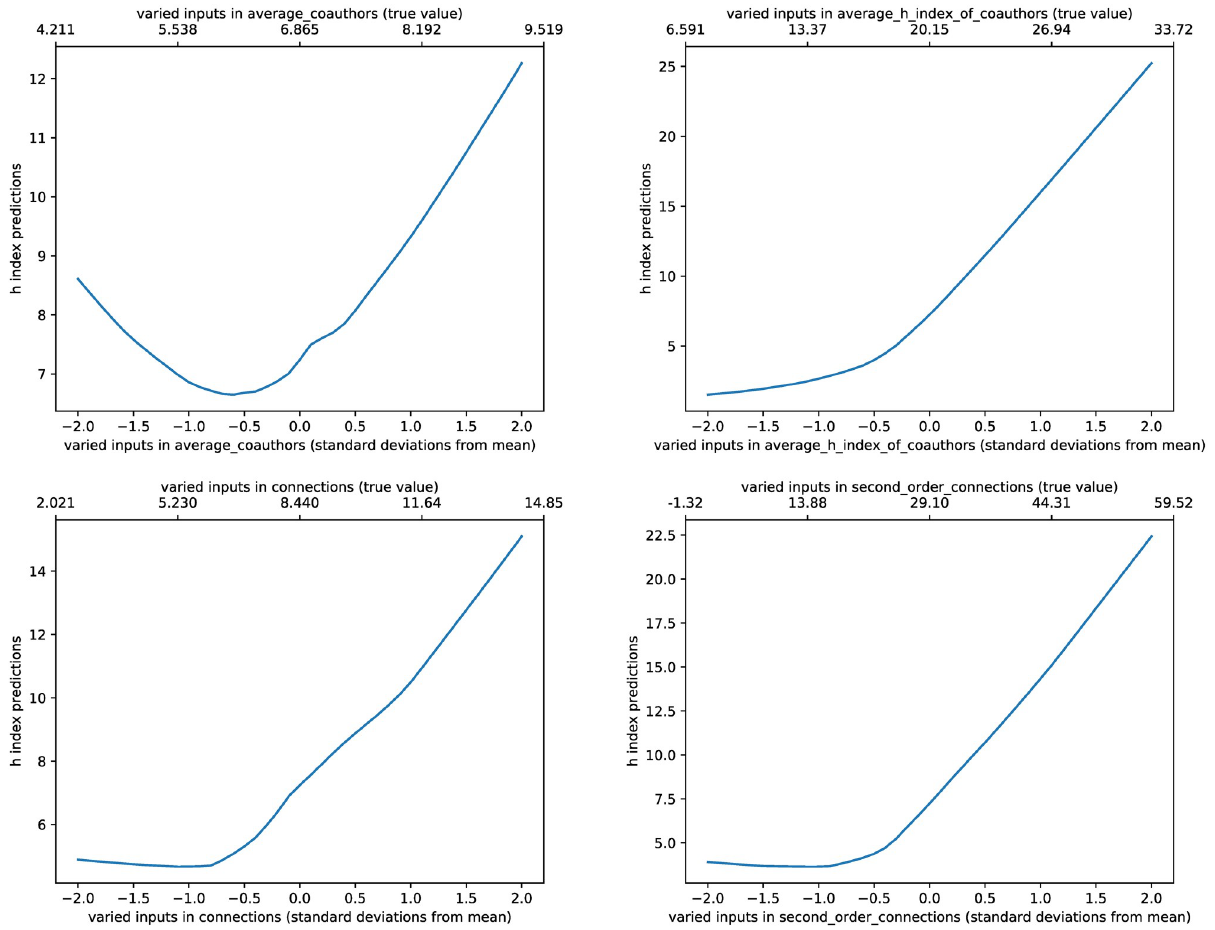
Fig 6. Variation in predicted H-Index with author connectedness statistics. The bottom axis shows the standard deviations from the mean; the top axis shows the actual